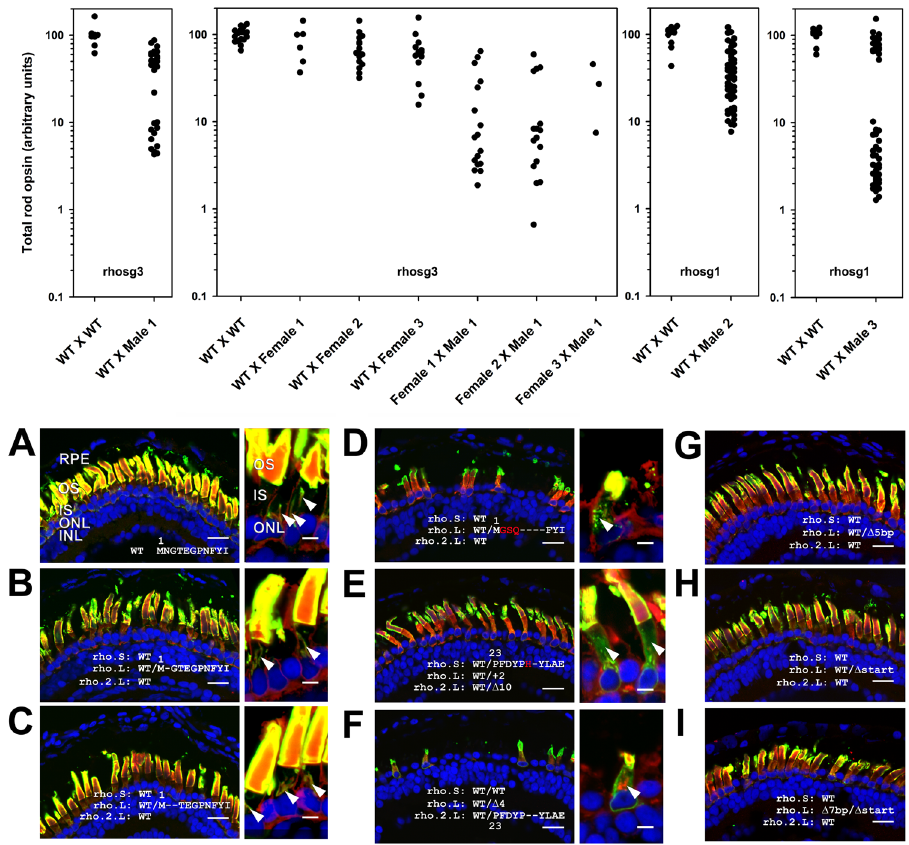
Each X-axis point represents offspring of a single mating, for which the F0 parents are indicated as being WT and/or F0 animals (named Male 1, Male 2, etc.). Each plot represents samples analyzed on a separate dot blot, and all animals on each plot were modified using the same sgRNA, indicated at the bottom of the plot. ( A – I ) Phenotypes of F1 animals assessed by confocal microscopy. ( A ) Wildtype. ( B – I) genetically modified (genotypes indicated on panels, for frame-conserving mutations the altered amino acid sequence is shown, with inserted amino acid residues shown in red). ( B,C ) frame-conserving mutations with minimal phenotype. ( D–F ) frame-conserving indels with significant RD phenotypes. ( G – I) frame shifting indels. ( A–C ) High magnification panels: frame-conserving indels generating minimal or no RD phenotype do not alter rhodopsin localization, which is largely confined to outer segments (OS) and wheat germ agglutinin-positive inner segment (IS) membranes (arrowheads). ( D–F ) High magnification panels: frame-conserving indels generating significant RD phenotypes alter rhodopsin localization in inner segments causing a punctate distribution ( D , arrowhead) or diffuse labeling consistent with ER retention ( E , F , arrowheads). Green: anti-rhodopsin (B630N – A-I or 514–18 A-D high mag). Red: anti-rod transducin. Blue: Hoechst 33342. Bars = 20 µ m (low mag) or 5 µ m (high mag). RPE: retinal pigment epithelium. OS: outer segments. IS: inner segments. ONL: outer nuclear layer. INL: inner nuclear